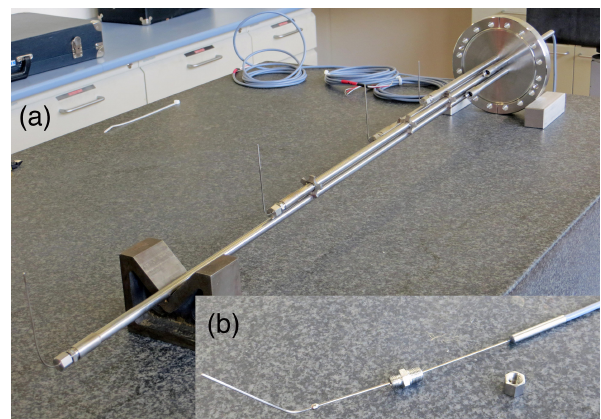
Figure A1. The horizontal calibration string (PTH) showing (a) the string during assembly, with four of the six Pt100 sensors mounted and (b) a single Pt100 sensor before being mounted on the string (a 1.5mm diameter stainless steel sheath surrounds the actual Pt100 sensor). The calibration strings are designed to allow the sensors to be dismounted without disconnection from their readout electron-